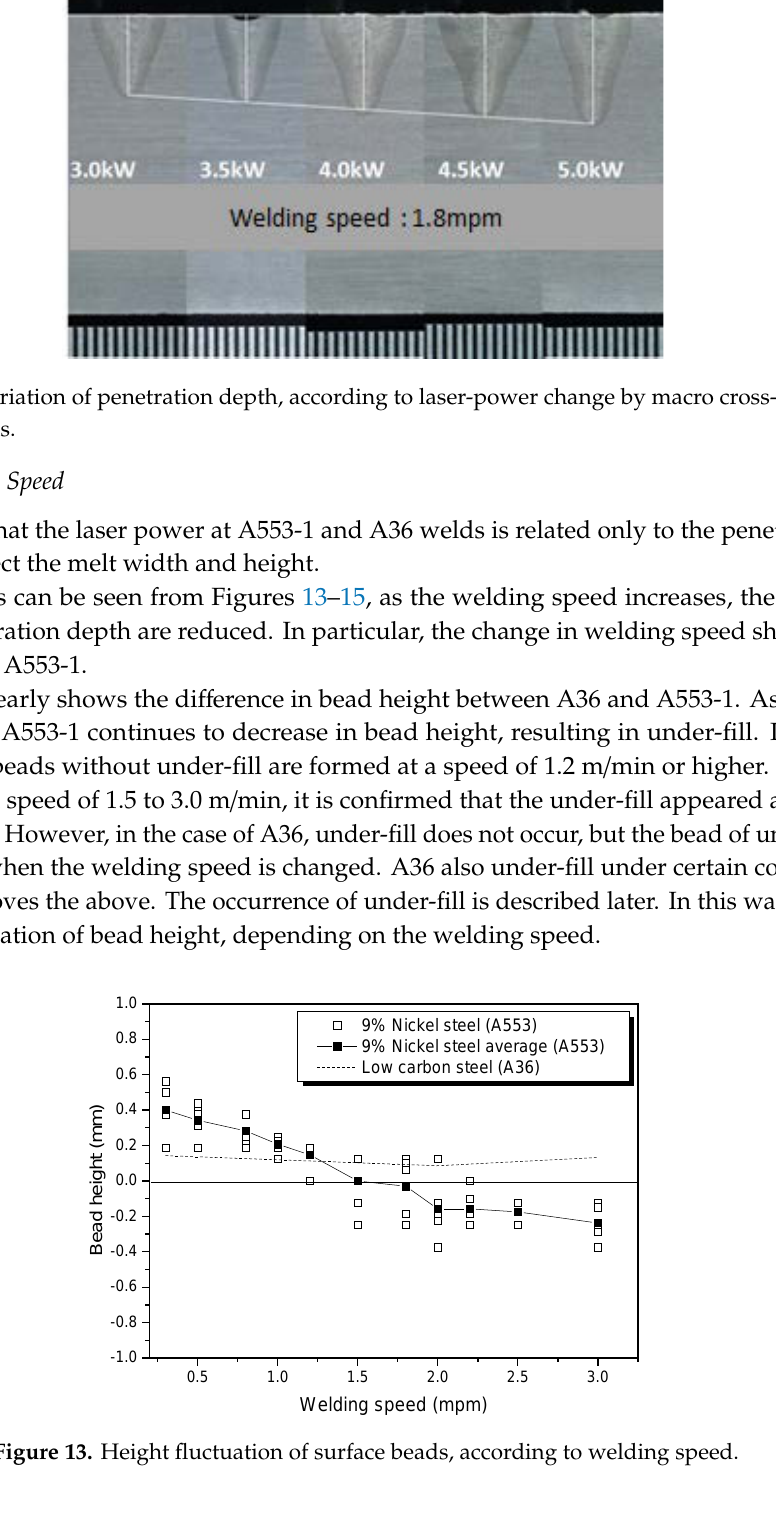
Figure 13. Height fluctuation of surface beads, according to welding speed.